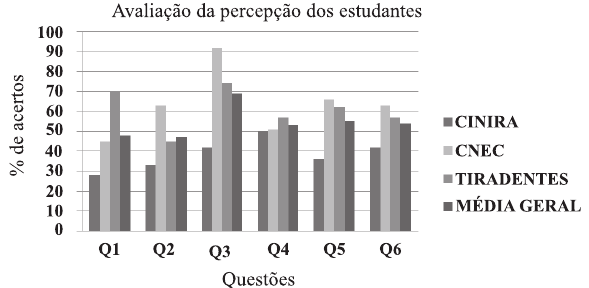
Figura 7. resultado da avaliação da percepção dos estudantes sobre Microbiologia do Solo das três escolas pesquisadas. a barra “média geral” representa a média de acertos das três escolas para cada